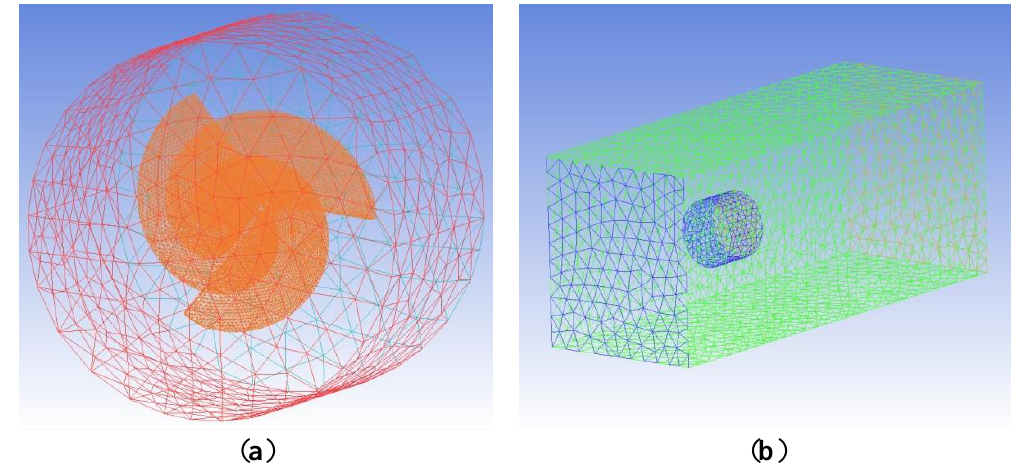
Figure 3. Meshing of the rotating and stationary domain.